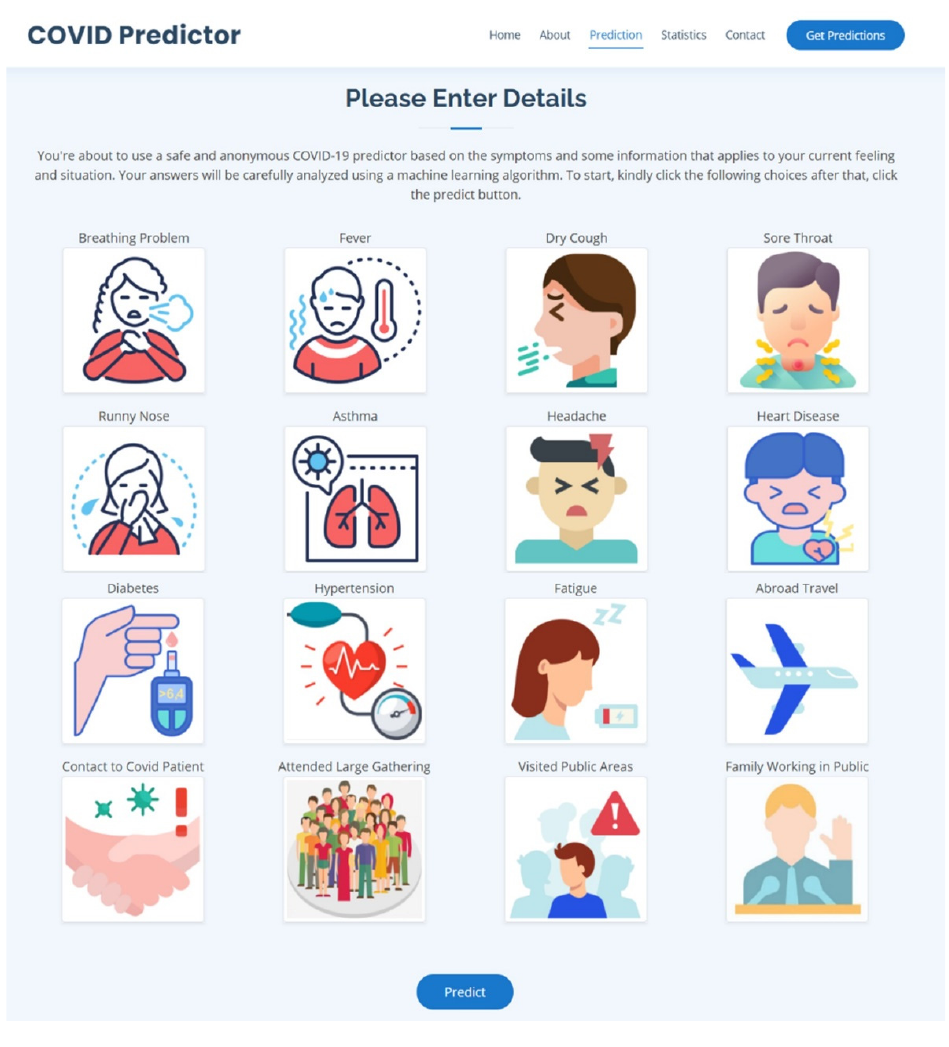
Figure 10. The COVID-19 Prediction section.